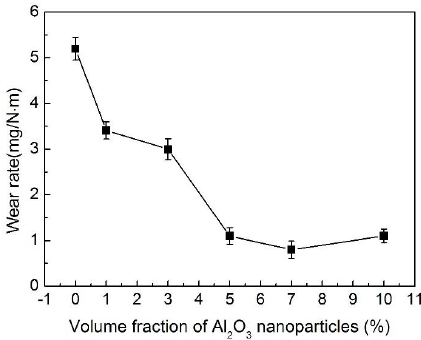
Figure 20. Wear rate of rheoformed 2024 aluminum matrix composite component reinforced by different volume fraction Al 2 O 3 nanoparticles at 620 °C for 25 min stirring time.